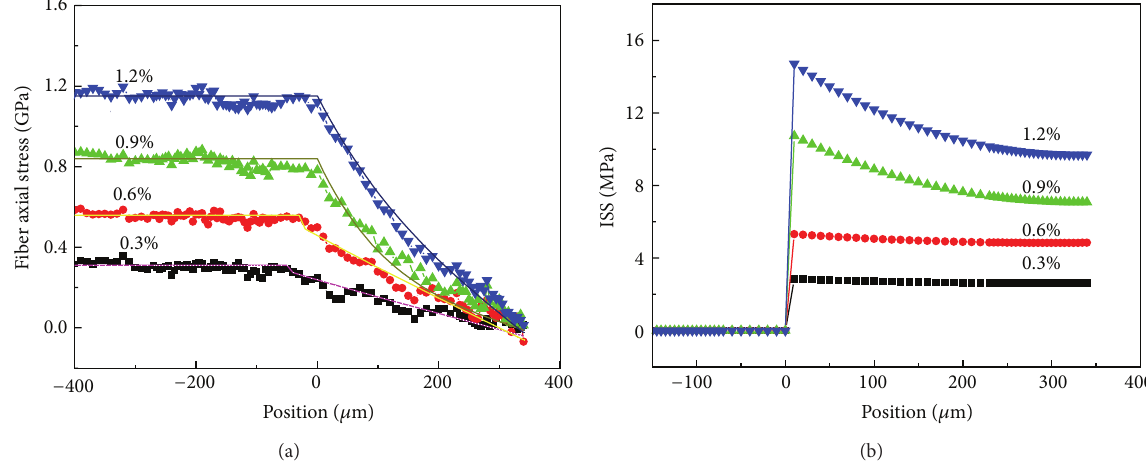
Figure 6: (a) Fiber axial stress and (b) shear stress distributions along fiber of pullout specimen under different strain levels [15].